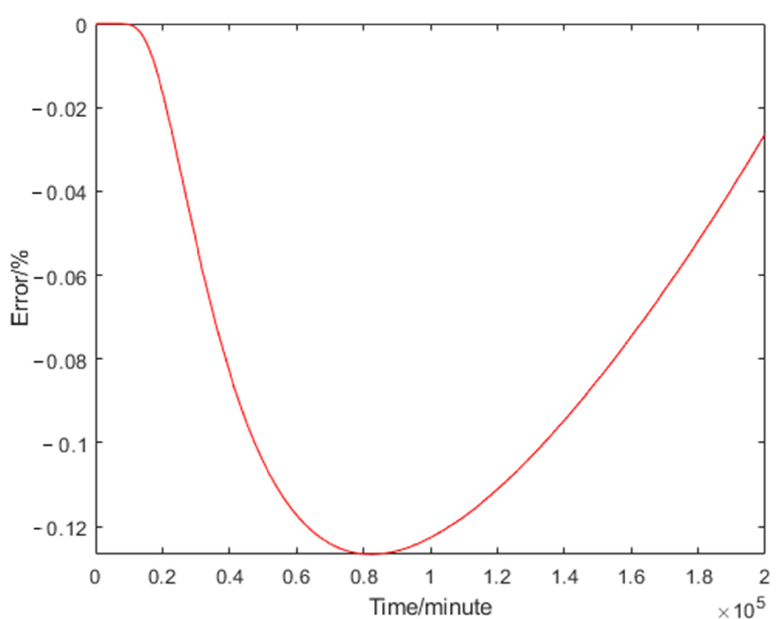
Figure 8. Error between degradation parameter life prediction method and failure number life prediction method.